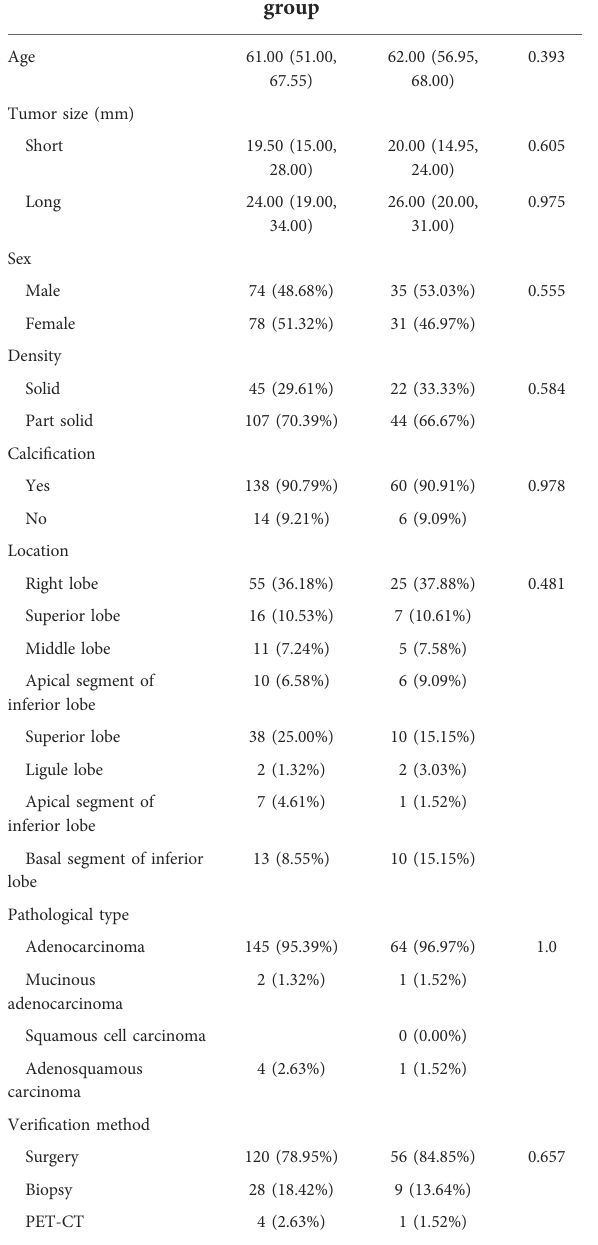
TABLE 3 Clinical data of patients in the training group and test group. TABLE 4 Coef fi cient of features in the unenhanced and enhanced